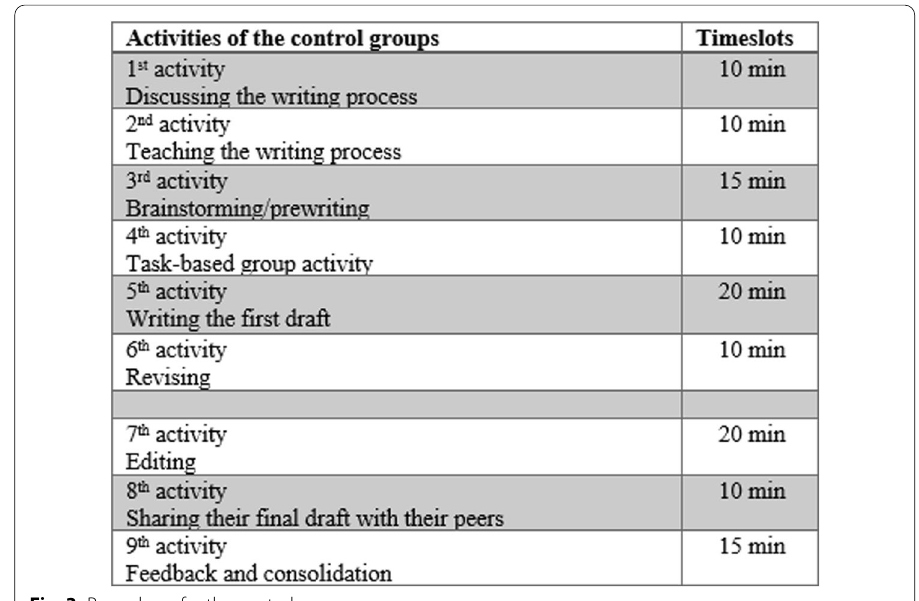
Fig. 3 Procedures for the control